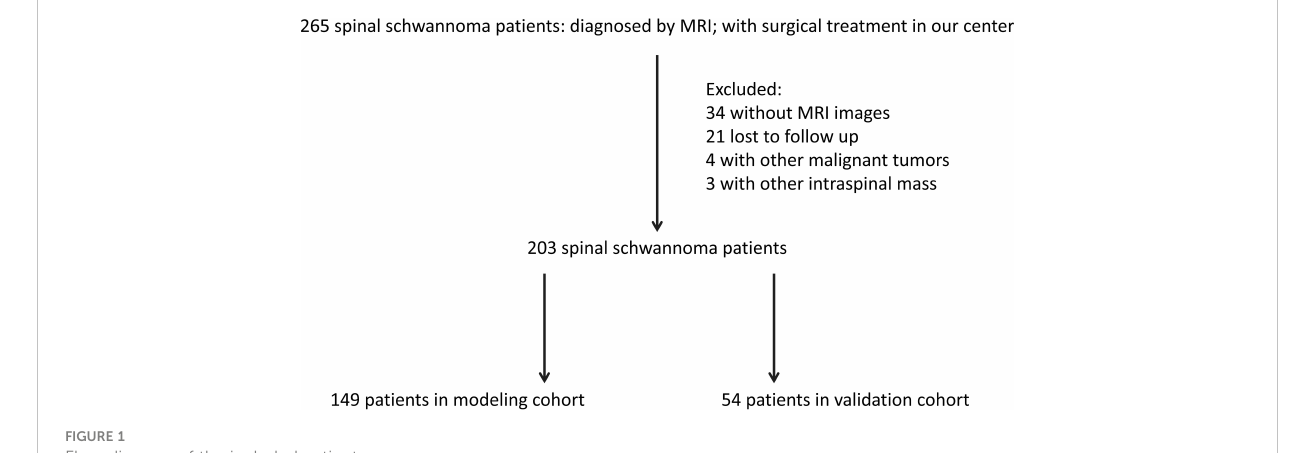
FIGURE 1 Flow diagram of the included